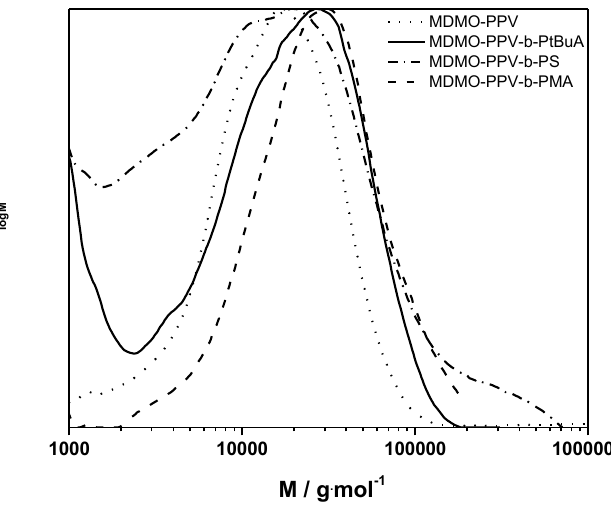
Figure A4. GPC profile of bromine functionalized MDMO-PPV and MDMO-PPV- b - P t BuA, MDMO-PPV- b -PS, MDMO-PPV- b -PMA block copolymers using